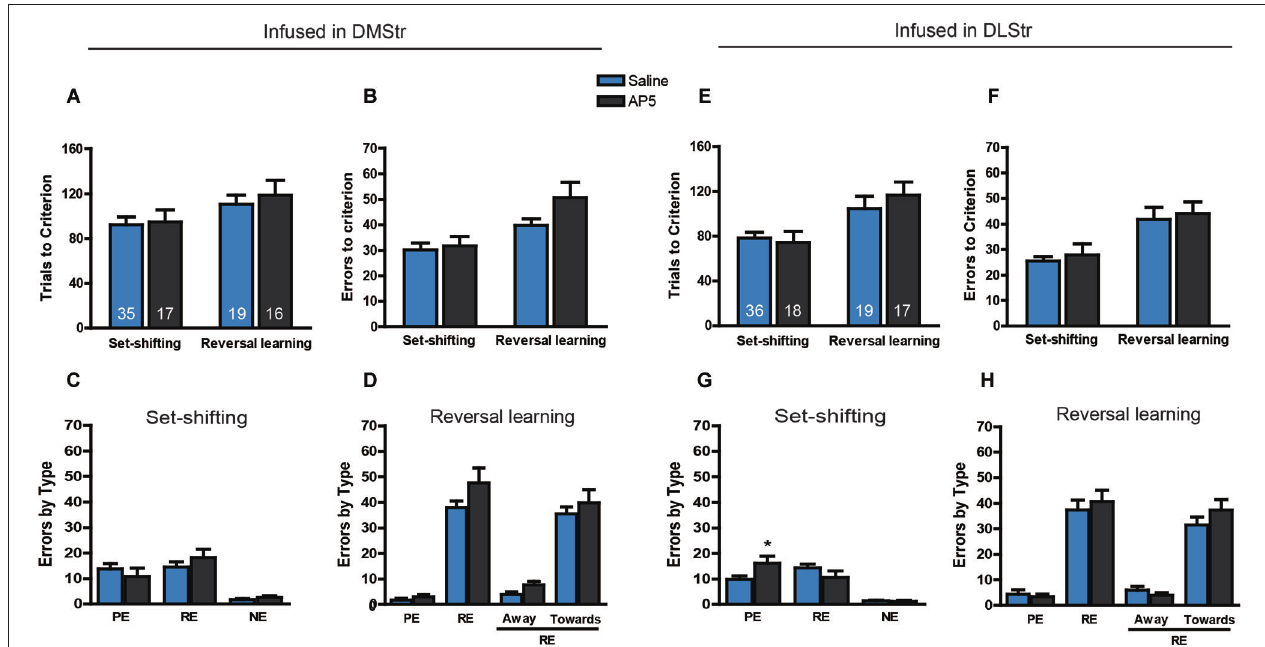
errors during set-shifting (C) and reversal learning (D) in rats that received AP5 treatment in the DMStr. (E) Number of trials and (F) number of errors to reach criterion in the set-shifting and reversal learning tasks following intra-DLStr infusions. (G,H) Analysis of the types of errors during set-shifting (G) and reversal learning (H) in rats that received AP5 treatment in the DLStr. * p < 0.05. PE, perseverative error; RE, regressive error; NE, non-reinforced error. During the reversal learning task, regressive errors were further divided into “away” and “toward” the visual